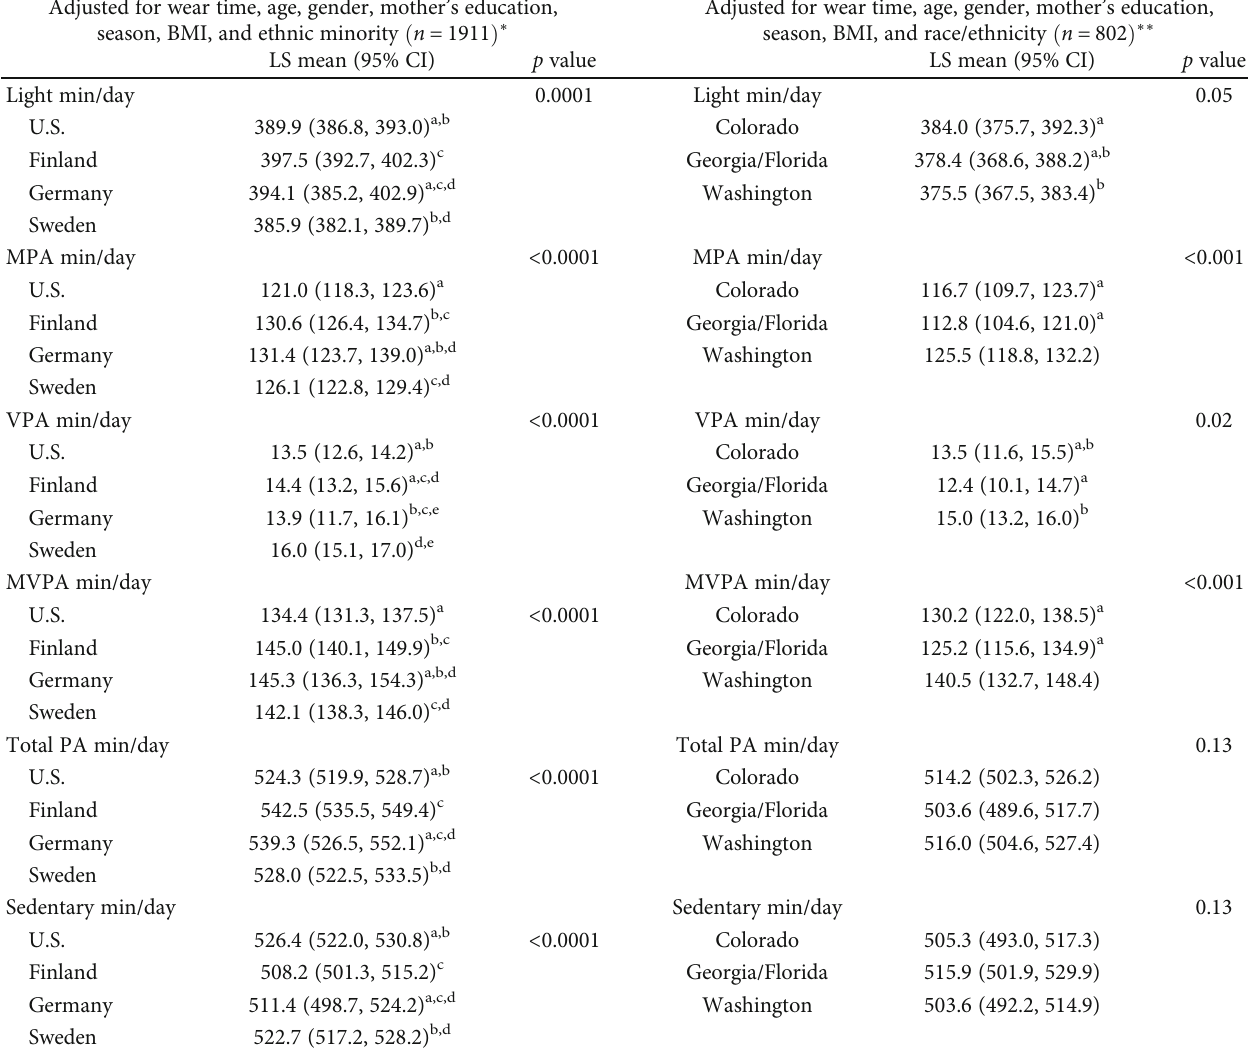
Table 3: Comparison of countries and regions within the U.S. for time spent in light, moderate (MPA), vigorous (VPA), moderate-to- vigorous (MVPA), total physical activity (TPA), and sedentary behavior (minutes per day). Adjusted for wear time, age, gender, mother ’ s Adjusted for wear time, age, gender, mother ’ s education, season, BMI, and ethnic minority n = 1911 ð Þ ∗